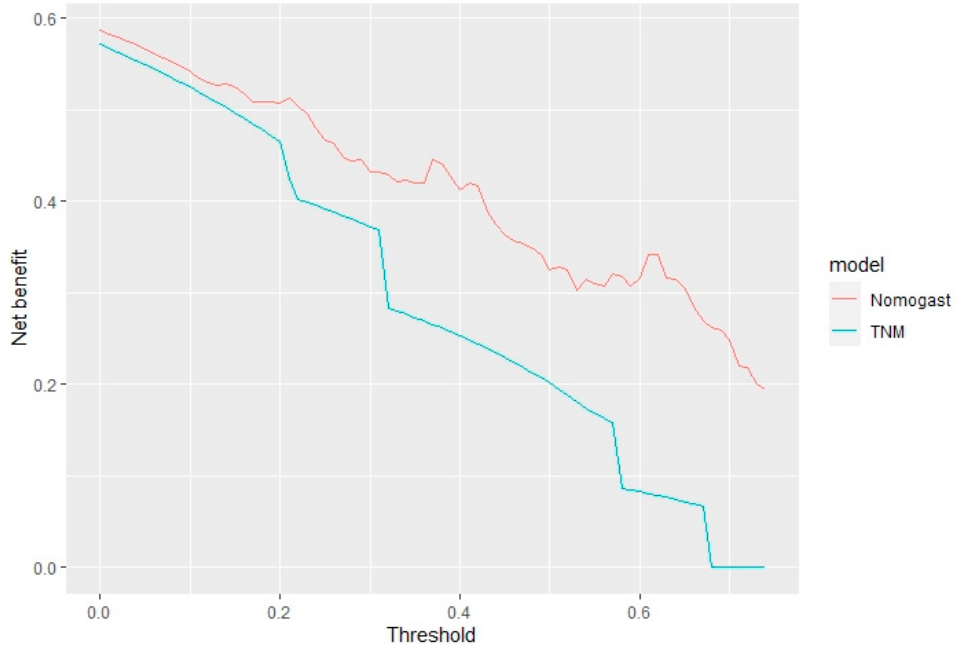
Figure 6. Comparison of clinical utility between the NOMOGAST and TNM staging systems.